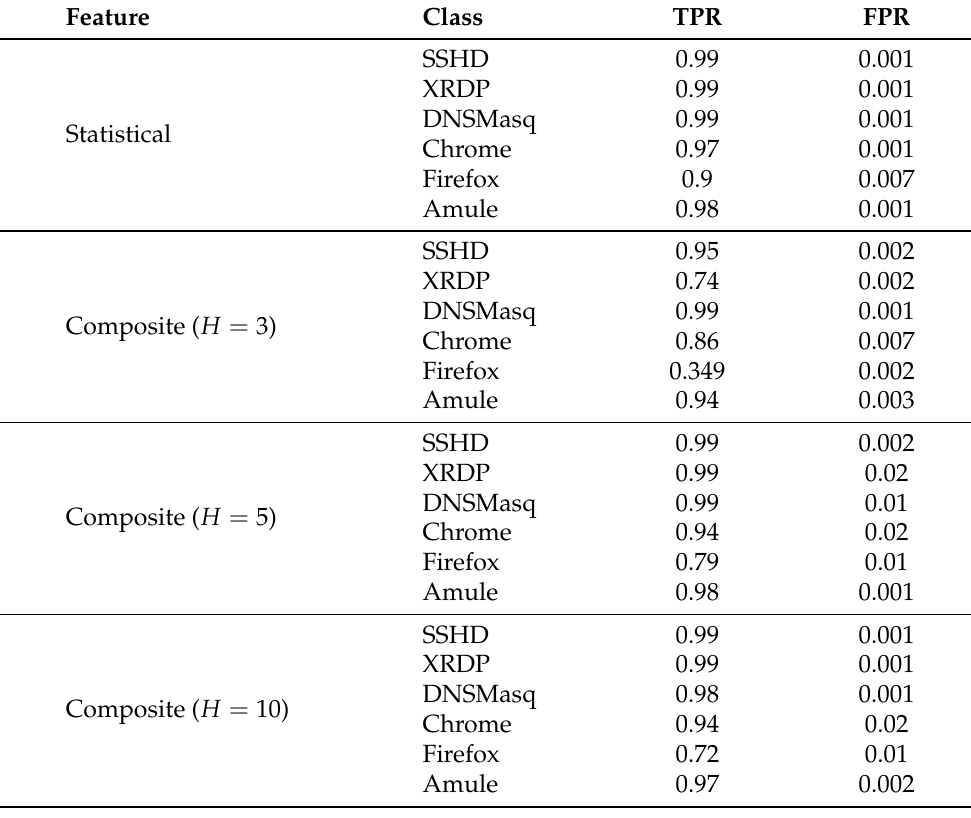
Table 10. C4.5: Performance over UPC data set.